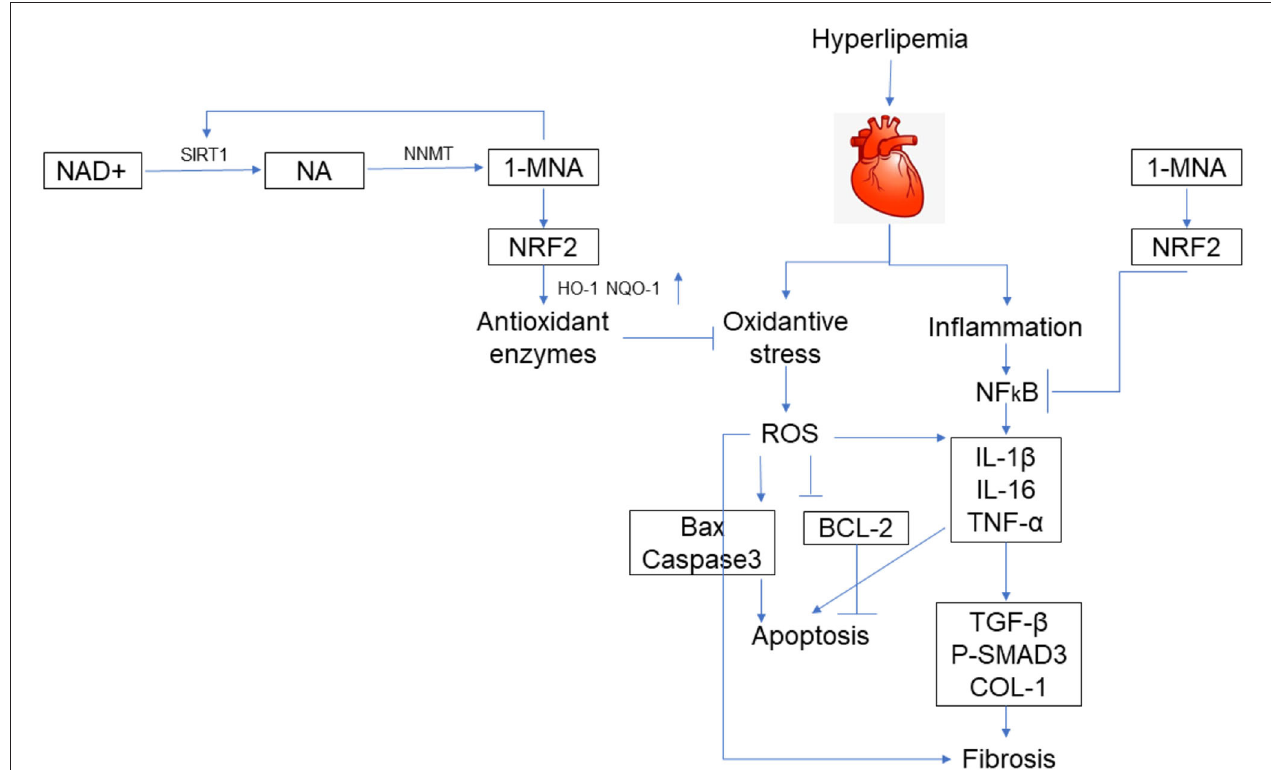
FIGURE 9 | Schematic illustration. A schematic illustration for the prevention of 1-MNA from FFA/HFD-induced injury in cardiomyocytes and hearts.